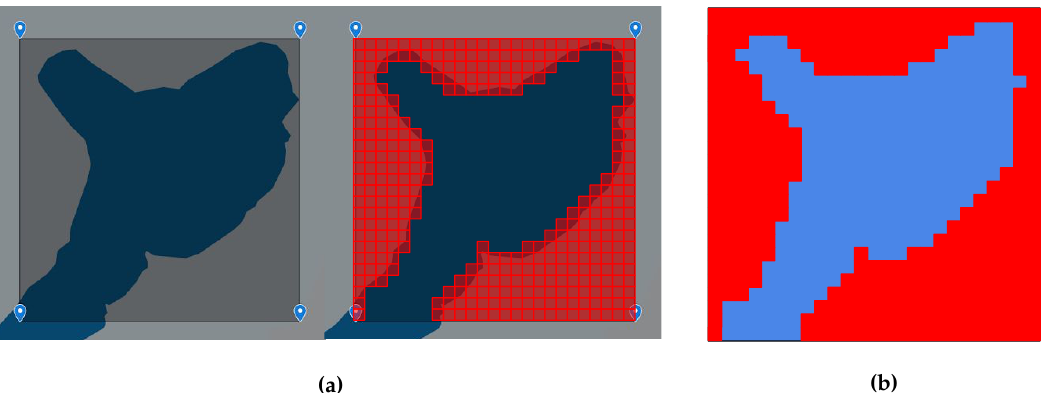
Figure 5. Creation of the image that will be used to generate the blocks matrix. In the most left image ( a ) we show part of Bonfim Lake (Natal, Brazil) inside the area of interest. Notice that in the center image, the red squares are placed on borders and obstacles. The right image ( b ) corresponds to the input of the algorithm to generate the block matrix.